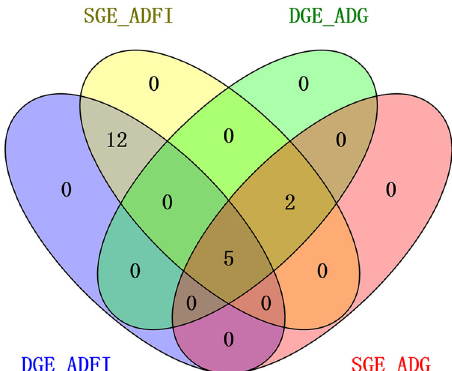
Fig. 4 The common SNPs were shared by both direct genetic effects (DGE) and social genetic effects (SGE). Venn diagram of common signi fi cant SNPs of DGE and SGE in average daily feed intake (ADFI) and average daily gain